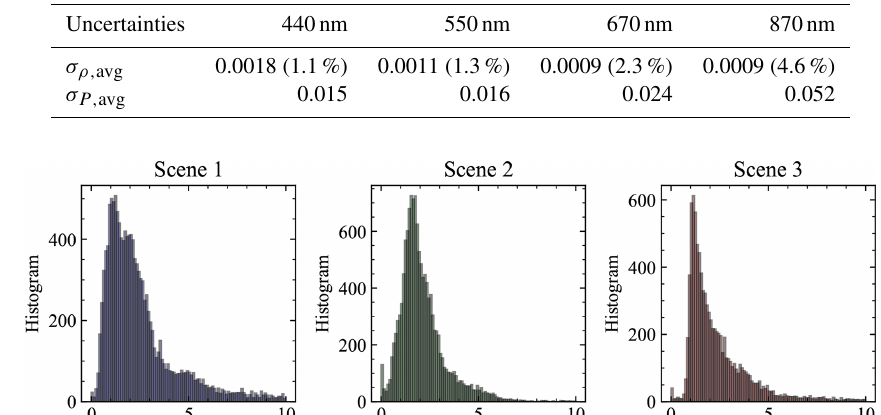
Table 5. The standard deviations of the reflectance ( σ ρ, avg ) and DoLP ( σ P, avg ) are calculated within a 10 × 10 pixel box and averaged over all angle and pixels from the three scenes (over ocean pixels only). The percentage values listed in the table indicate the percentage uncertainties.